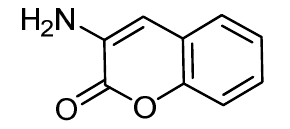
Figure 1. The structure of